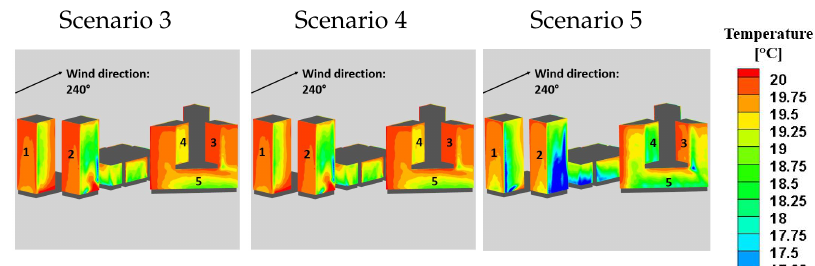
Figure 11. Contours of temperature at the surface of green